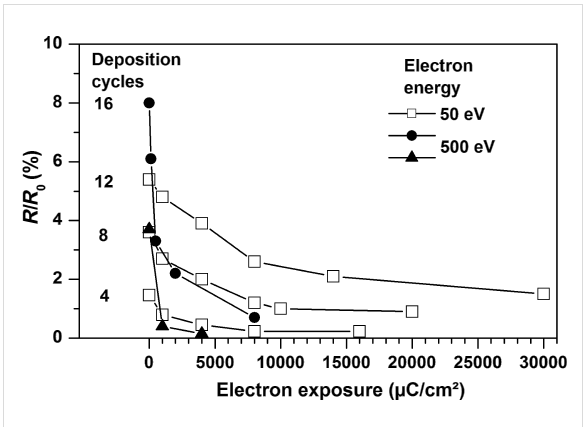
Figure 3: Intensity of the asymmetric CO 2 deformation band at 830 cm − 1 after increasing electron exposures at 50 eV (open symbols) and 500 eV (closed symbols) of surface-grown copper(II) oxalate pre- pared by performing different numbers of deposition